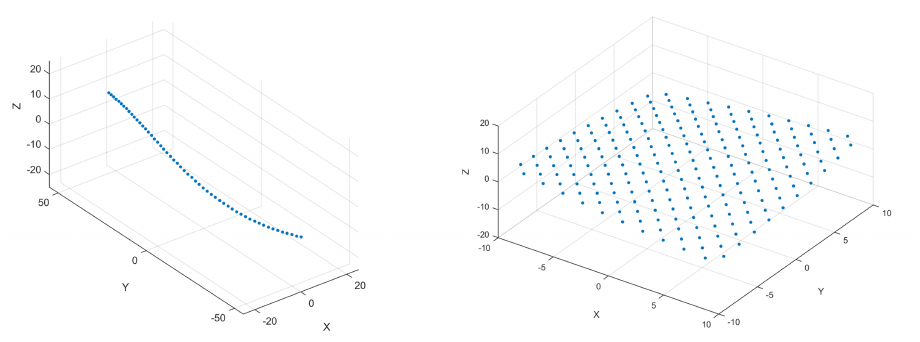
Figure 2. For each quantum state, one can try to determine the emergent geometry using multi- dimensional scaling, which rearranges the vertices of the “information graph” according to their relative distances. Two resulting reconstructions from the algorithm are shown, where each blue dot is a graph